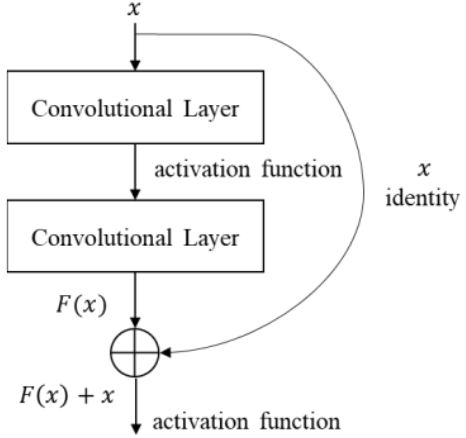
Figure 3. Residual block structure in Resnet.